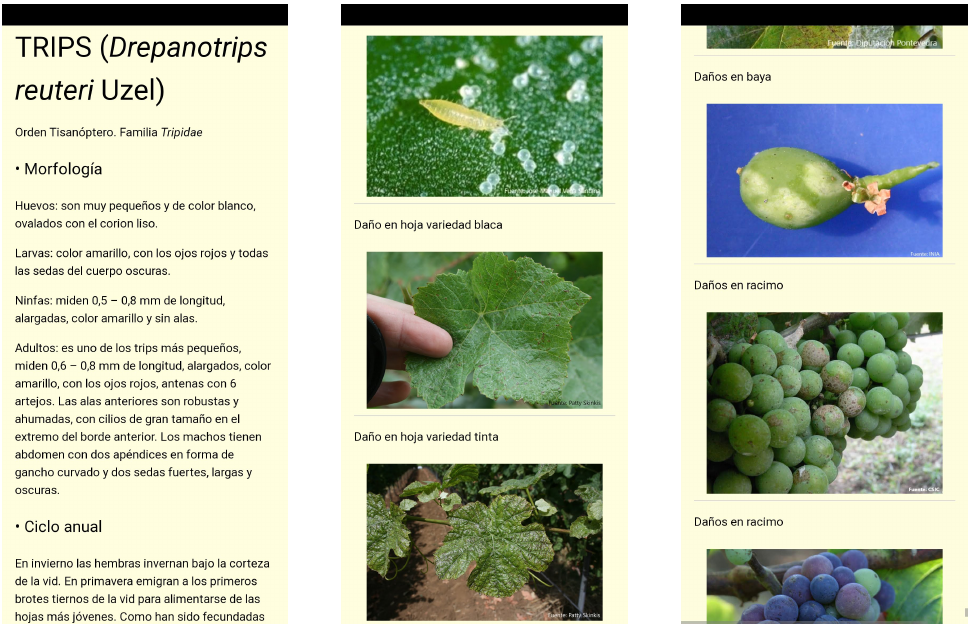
Figure 2. Description of Drepanotrips reuteri